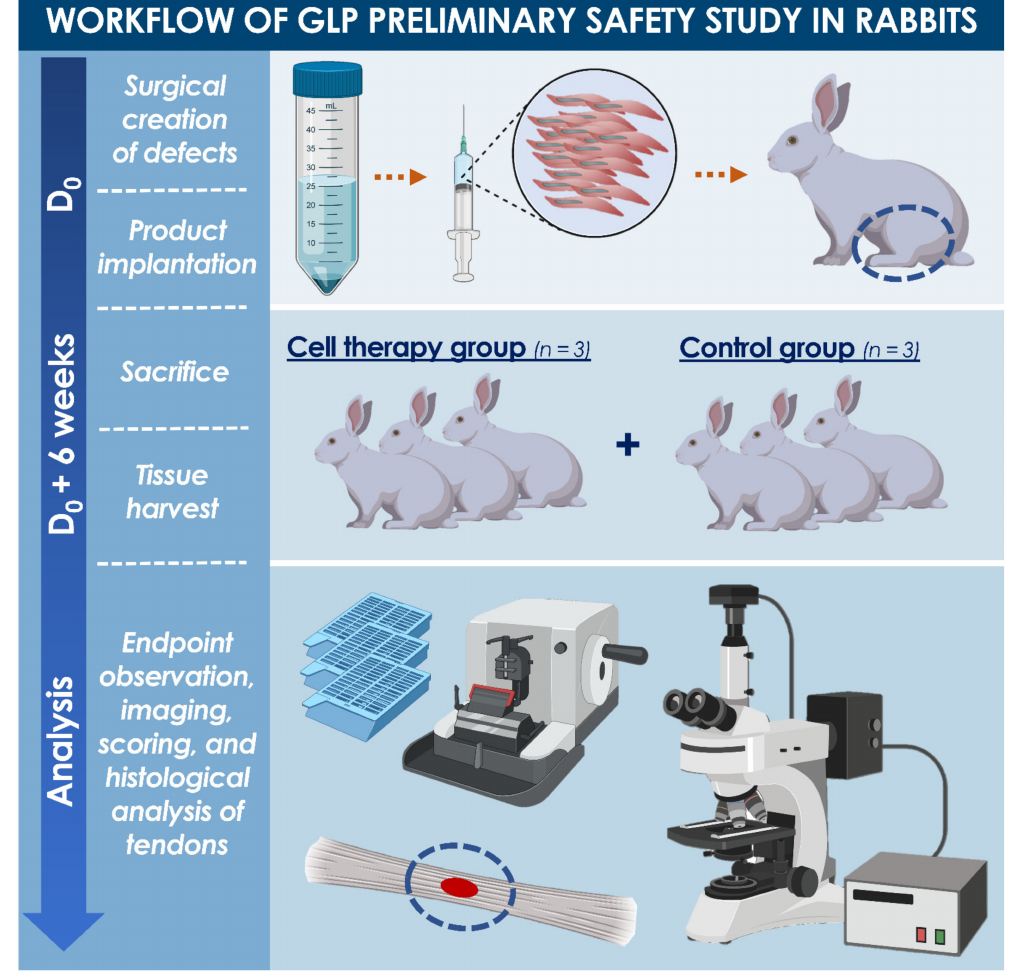
Figure 1. Workflow of the GLP preliminary safety study of hFPTs performed on a rabbit model of partial-thickness patellar tendon defect. On the day of defect creation, viable hFPTs were suspended in hyaluronic acid gels and delivered into the tendon defect, before suturing it closed, as well as the skin. A total of 6 weeks later, all rabbits were sacrificed, and tendons of interest were macroscopically assessed and harvested for histological processing and macroscopic evaluation, looking at potential early local adverse effects. GLP, good laboratory practice; hFPT, human fetal progenitor